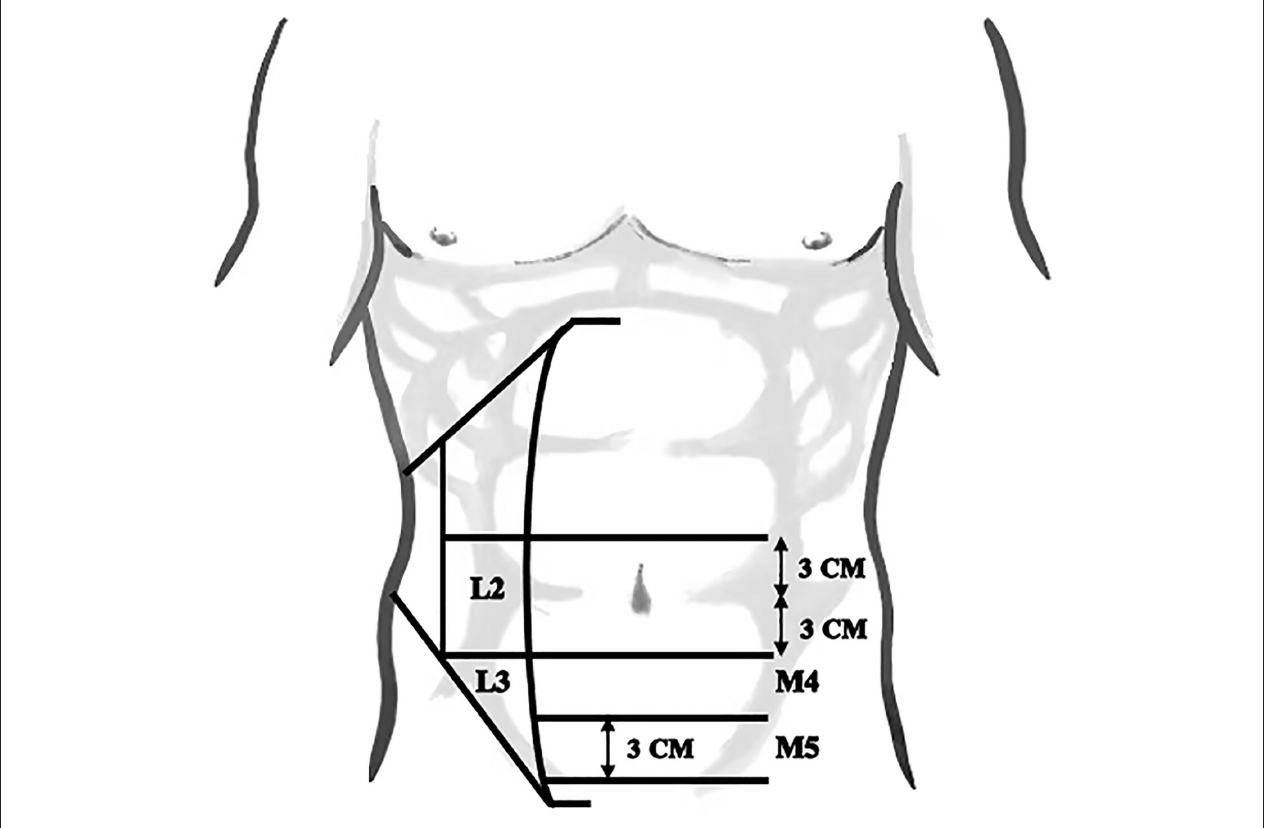
FIGURE 1 | To classify the lower abdominal marginal hernia, four zones were defined according to the European Hernia Society (EHS)